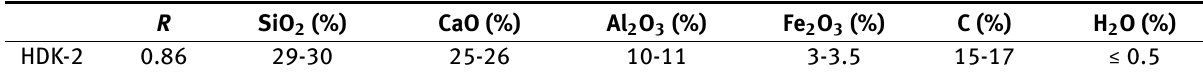
Table 2: Basicity and chemical composition of mould slag. R